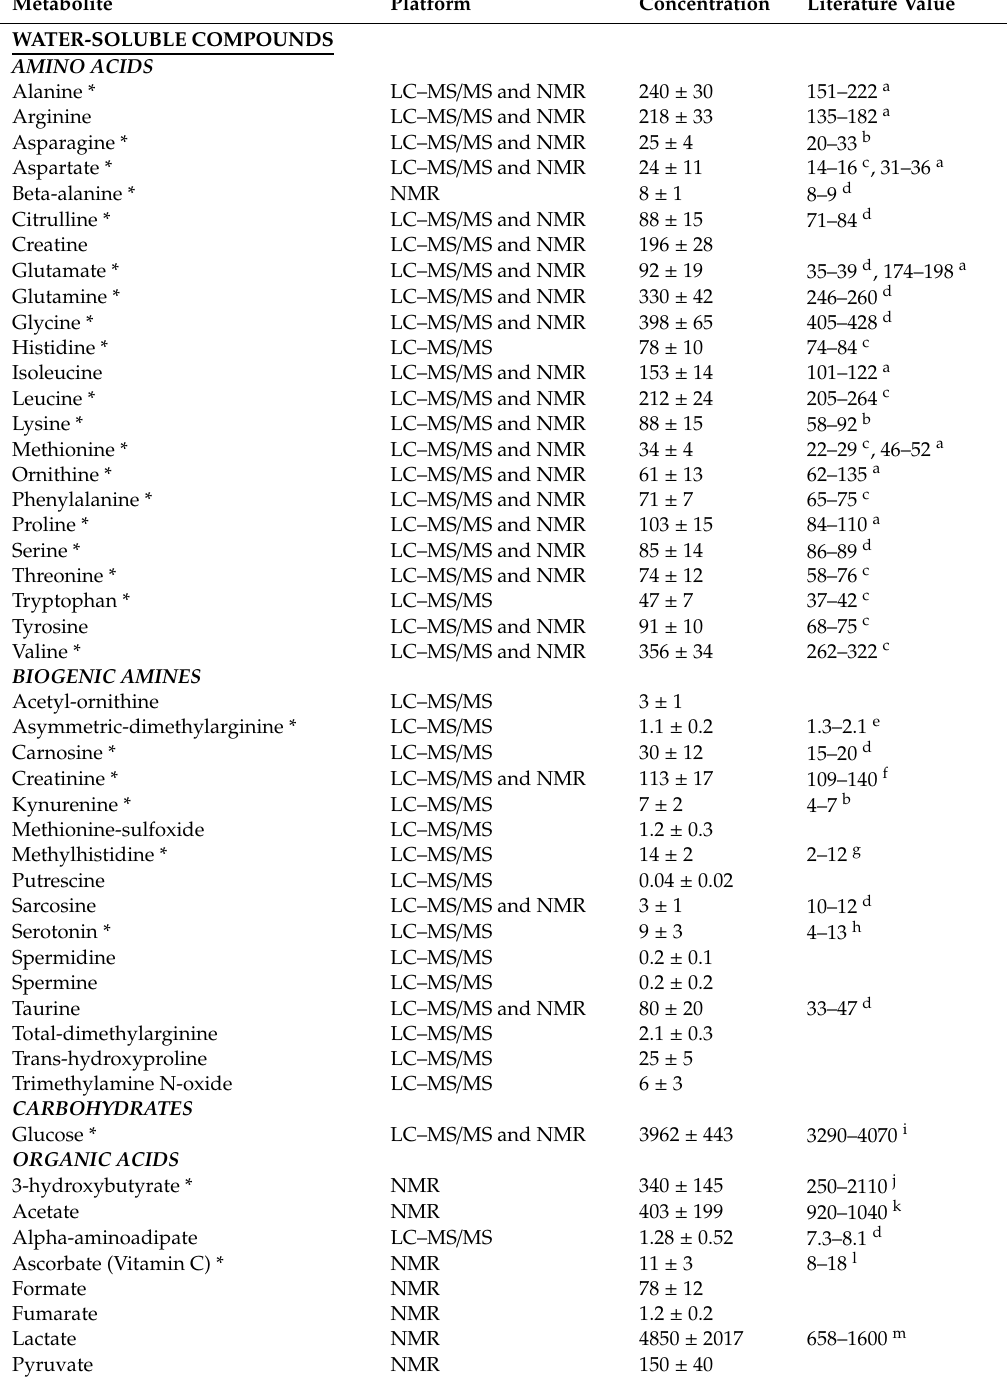
Table 1. List of serum metabolites along with their measured or reported concentrations and their standard deviations and / or ranges (as measured in µ